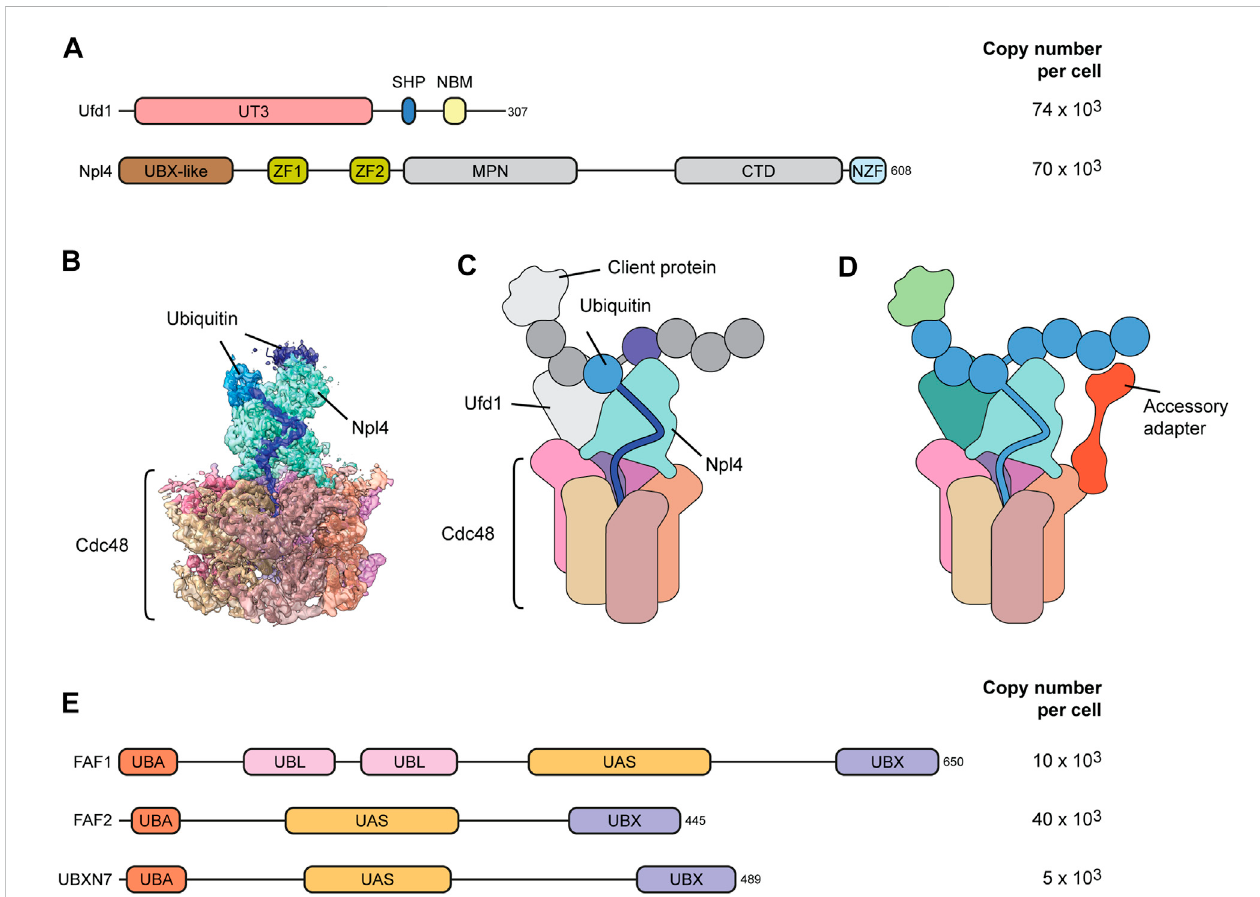
FIGURE 3 Adapterandaccessoryadaptersforubiqutin-mediatedtargeting. (A) DomainstructureofthemajorUfd1-Npl4clientadapter.Ufd1-Npl4isaheterodimer thatbindsp97 cooperatively via interactionsofaUBX-like(UBXL)domain inNpl4 andaSHP boxinUfd1withp97 N-domains.Thezinc fi ngers(ZF1andZF2)in Npl4 make contact with the top of the D1 ring. The UT3 domain in Ufd1 and the C-terminal domain (CTD) in Npl4 bind and position the ubiquitin chain. The ubiquitin-binding NZF is speci fi c for metazoan Npl4. NBM, Npl4 binding motif. MPN, Mpr1, and Pad1 N-terminal domain. Copy numbers of indicated proteins compared to roughly 230 × 10 3 p97 hexamers in human U2OS osteosarcoma cells according to (Beck et al., 2011). (B) Cryo-EM structure (pdb 6OA9 and EMD-0665) of yeast Cdc48-Ufd1-Npl4 with a ubiquitinated model substrate in the central pore. Dark blue depicts one unfolded ubiquitin moiety bound to a groove in Npl4 (cyan). Additional ubiquitin moieties are bound on top. (C) Cartoon model of the structure in (B) . Ufd1, the client and additional ubiquitin moieties are not resolved in the structure. (D) Speculative model for the function of accessory adapters such as FAF1, FAF2 or UBXN7. Accessory adapters enhance p97 af fi nity for the client by bridging p97 with the ubiquitin chain attached to the client, thereby assisting Ufd1-Npl4-mediated client targeting and unfolding. (E) Domain structure of p97 cofactor proteins that have been proven to act as accessory adapters cooperating with Ufd1-Npl4. They are characterized by UBX and UBA domains that bind p97 and ubiquitin, respectively, and possess a thioredoxin-like (UAS) domain of yet unknown function. UBL, ubiquitin-like